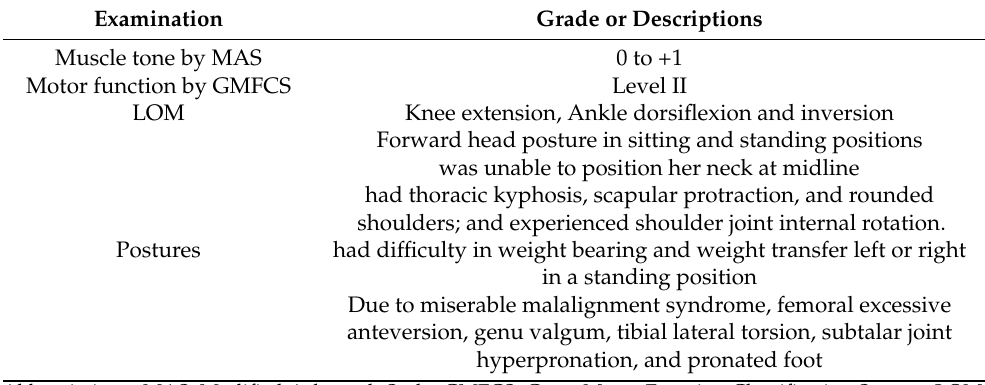
Table 1. Basic physical function of the subject. Examination Grade or Descriptions Muscle tone by MAS 0 to +1 Motor function by GMFCS Level II LOM Knee extension, Ankle dorsiflexion and inversion Forward head posture in sitting and standing positions was unable to position her neck at midline had thoracic kyphosis, scapular protraction, and rounded shoulders; and experienced shoulder joint internal rotation. Postures had difficulty in weight bearing and weight transfer left or right in a standing position Due to miserable malalignment syndrome, femoral excessive anteversion, genu valgum, tibial lateral torsion, subtalar joint hyperpronation, and pronated